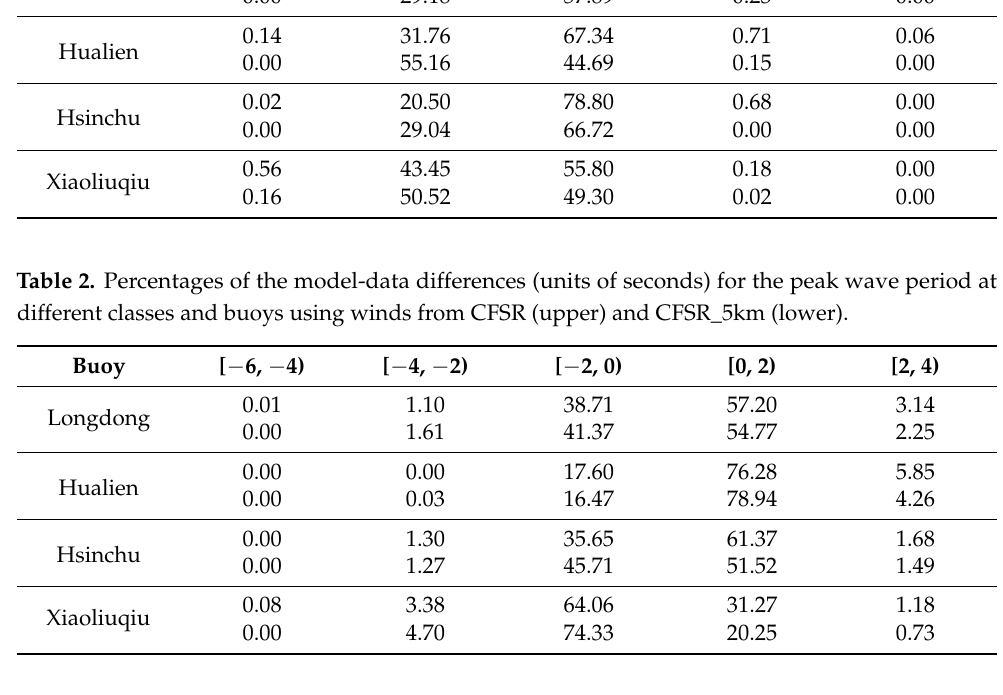
Table 3. Percentages of the model-data differences (units of degree) for the wave direction at different classes and buoys using winds from CFSR (upper) and CFSR_5km